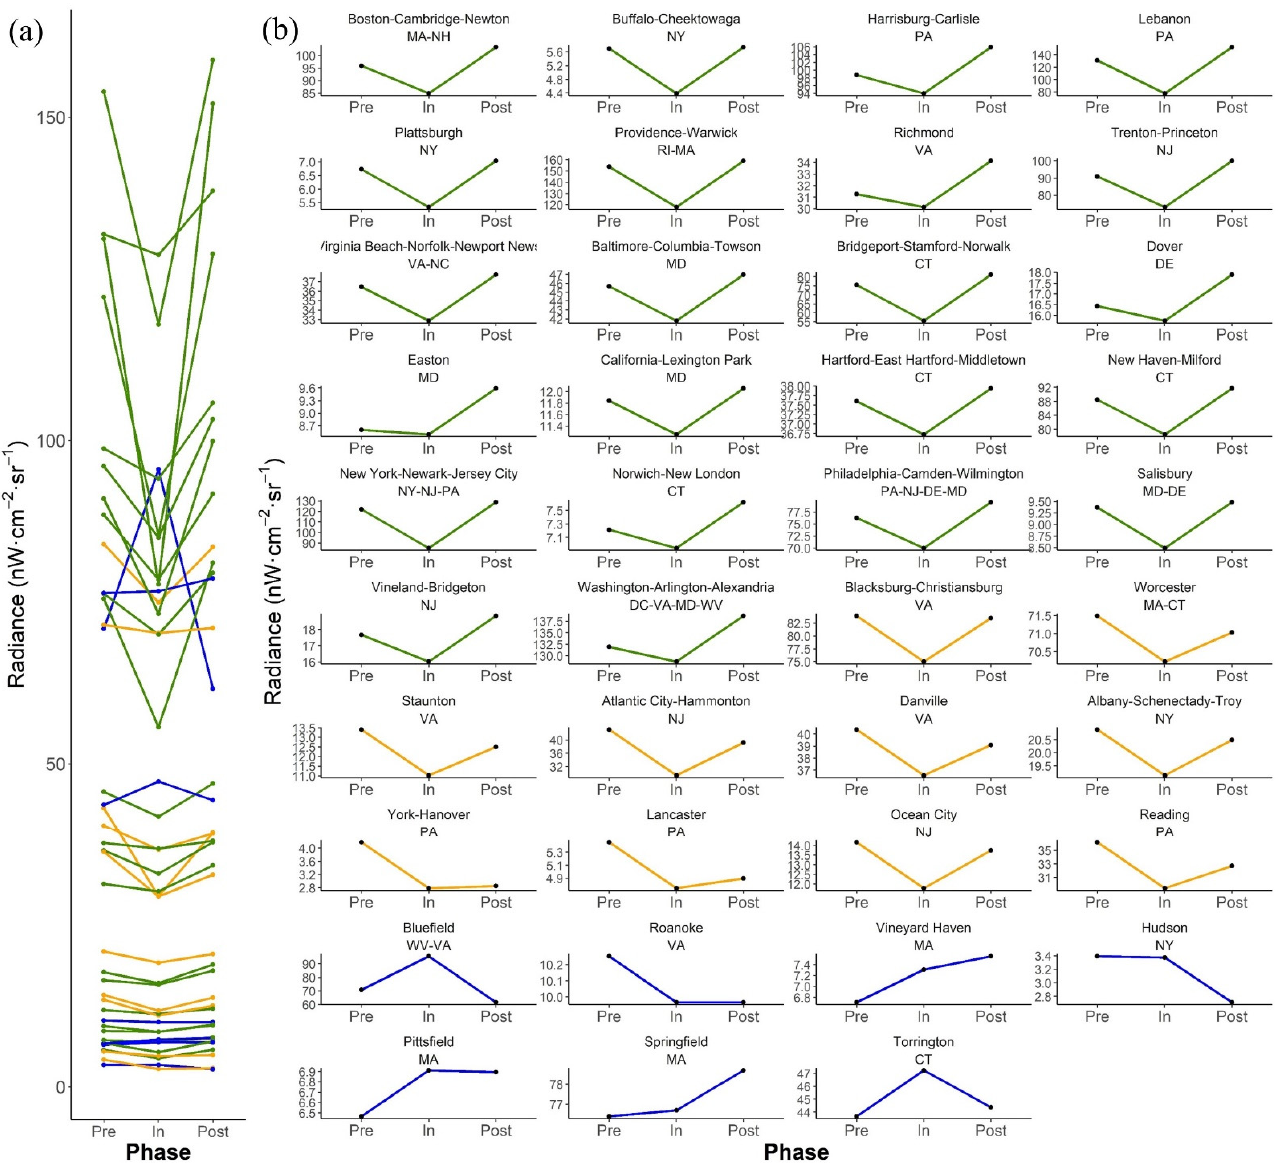
Figure 8. NTL radiance changes in 39 CBSAs in the Northeastern United States in the pre-, in-, and post-disaster periods: ( a ) NTL changes in a single plot (same scale in the y-axis); ( b ) NTL changes are shown in separate plots (different scales in the y-axis), CBSA name and state abbreviation is attached to the header of each plot to the right.